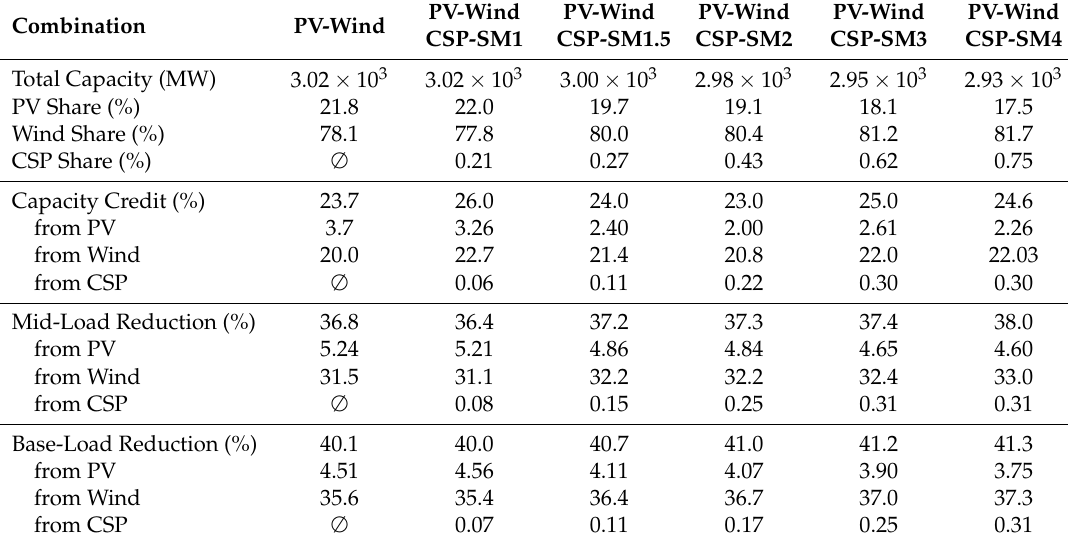
Table 10. Properties of the optimal mix at 27% penetration for the global strategy with the maximum-cost constraint and for different